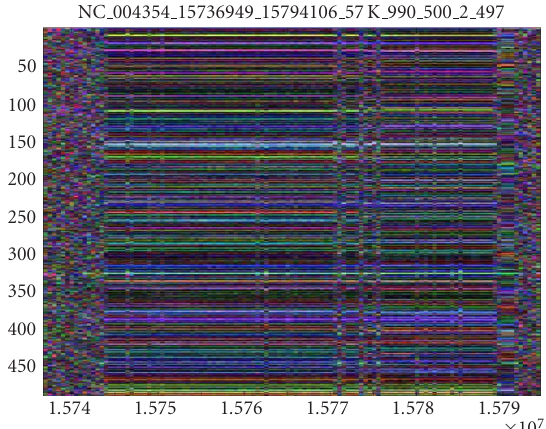
Figure 16: Spectrogram showing a minisatellite with repeat unit of length 95 bp in chromosome 3 of C. elegans . Slight variations in the basic repeat pattern can be seen as vertical lines that appear blurry. The minisatellite is interrupted by a small amount of nonre- peat DNA as well as an even simpler repeat unit of length 5kbp.